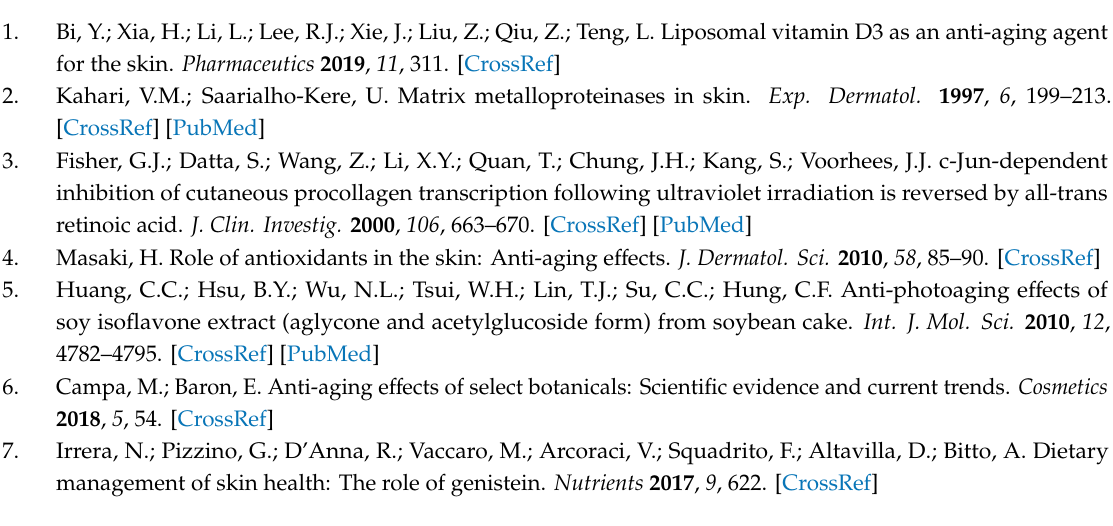
Figure S1: The color change of orobol (0.05%, w / w ) in various vehicles. (a) Samples immediately after the preparation; (b) samples stored at room temperature for 14 days without sunlight exposure; (c) samples stored at room temperature for 14 days with sunlight exposure, Figure S2: (a) The LC-MS / MS peak of orobol at a concentration of the lower limit of quantification (10.0 ng / mL); (b) the calibration standard curve of orobol at a final concentration range of 10.0 –1000 ng / mL, Figure S3: The color change of the orobol-loaded formulations. (a) Samples immediately after the preparation; (b) samples stored at room temperature for 14 days without exposure to sunlight; (c) samples stored at room temperature for 14 days with exposure to sunlight, Figure S4: (a) Morphological shapes of o / w ME formulation by TEM; (b) size distribution of o / w ME formulation. The scale bars represent 0.5 µ m, Figure S5: The change of mean particle size (left Y -axis; • ) and content (% of initial concentration; right Y -axis; ) in o / w ME formulation at room temperature on day 0 (initial state after the preparation), day 3, 7, 14, 21, and 28, Figure S6: In vitro deposition of orobol into a Strat-M membrane after applying orobol-loaded o / w ME (cid:35) formulation at the concentration of 0.5 mg / mL for 3 h and 6 h, Table S1: Criteria of the skin irritation score system by the guidelines of the International Contact Dermatitis Research Group (ICDRG) and the Personal Care Products Council (PCPC), Table S2: The standard procedure dermal classification system by the Environmental Protection Agency (EPA), Table S3: Skin irritation scores of the blank nanostructured lipid carrier (NLC) formulation (blank F4) and the orobol-loaded NLC formulation (F4) at 30 min, 24 h, and 48 h after topical application of the samples to human volunteers for 24 h, Table S4: Composition of o / w ME formulation (w / w, %) containing 0.05(w / w, %) of